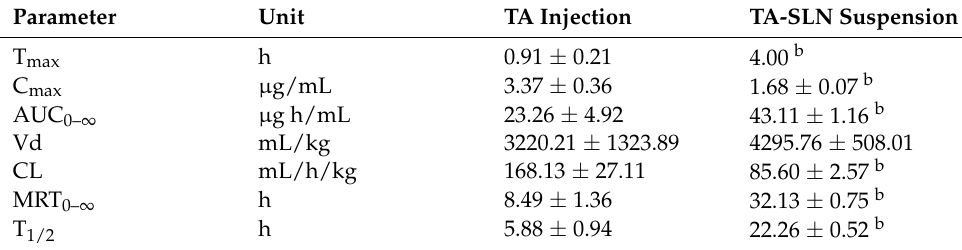
Figure 7. Concentration–time curves of the TA-SLN suspension and TA injection. Table 5. Pharmacokinetic parameters of TA in swine plasma after i.m. administration of TA injection and the TA-SLN suspension ( n = 6).